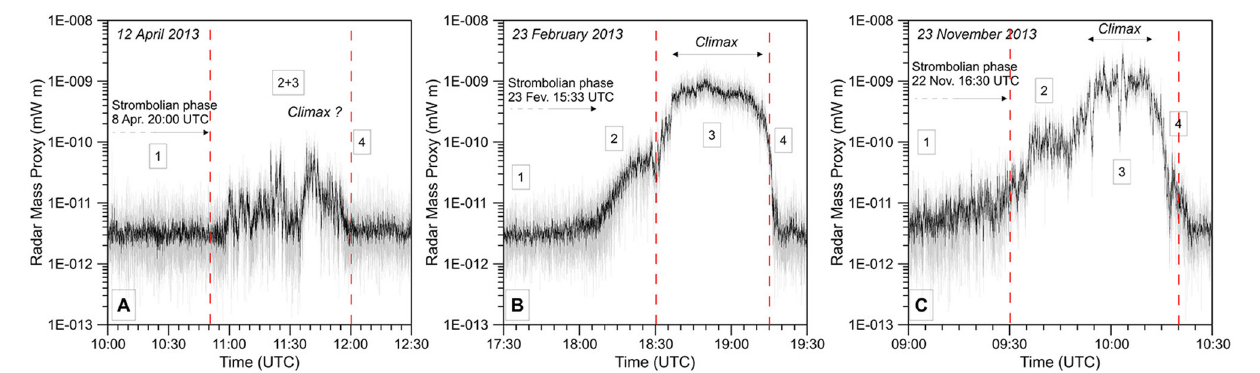
FIGURE 3 | Raw (gray) and 2.5-s running average (black) time series of the Radar Mass proxy recorded during lava fountain paroxysms of Etna’s NSEC on 12 April 2013 (A) , 23 November 2013 (B), and 23 February 2013 (C) . Radar-inferred eruption phases are numbered: (1) Strombolian activity, (2) Strombolian to lava fountain transition, (3) climax phase, and (4) waning phase including a sudden drop in activity marking the end of the lava fountain. Dashed red lines correspond to the onset and end times of the lava fountains according to De Beni et al. (2015).